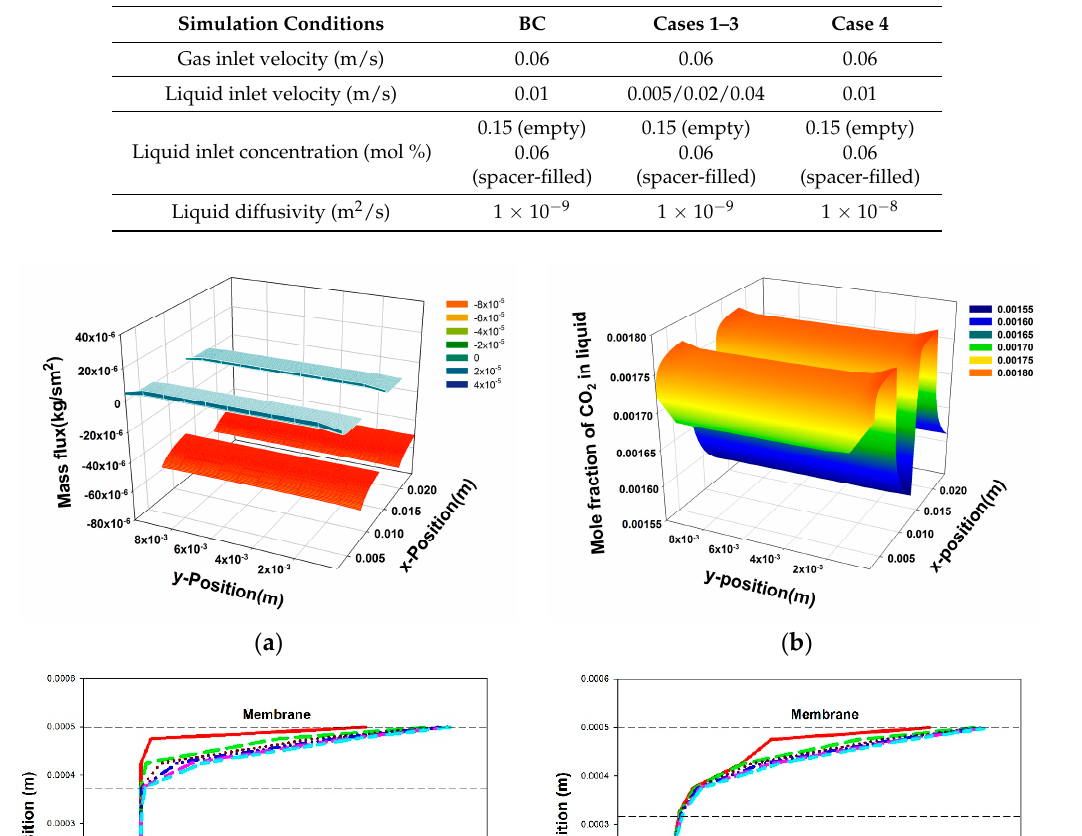
Table 2. Simulated cases for cross-flow HASMC.